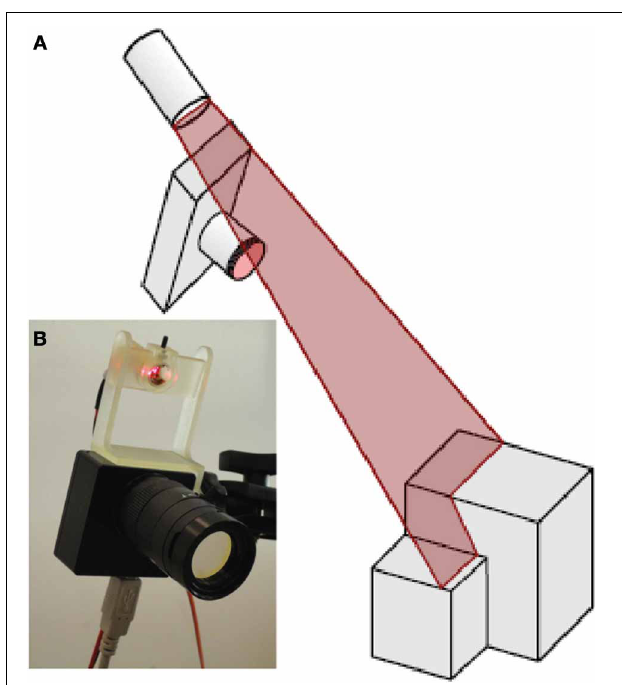
FIGURE 2 | Setup of the DVS together with the line laser. (A) Schematic view of the setup. (B) Photo of the DVS128 camera with line laser: the rigid laser mount allows a constant distance and inclination angle of the laser with respect to the camera. The optical filter is mounted on the lens.